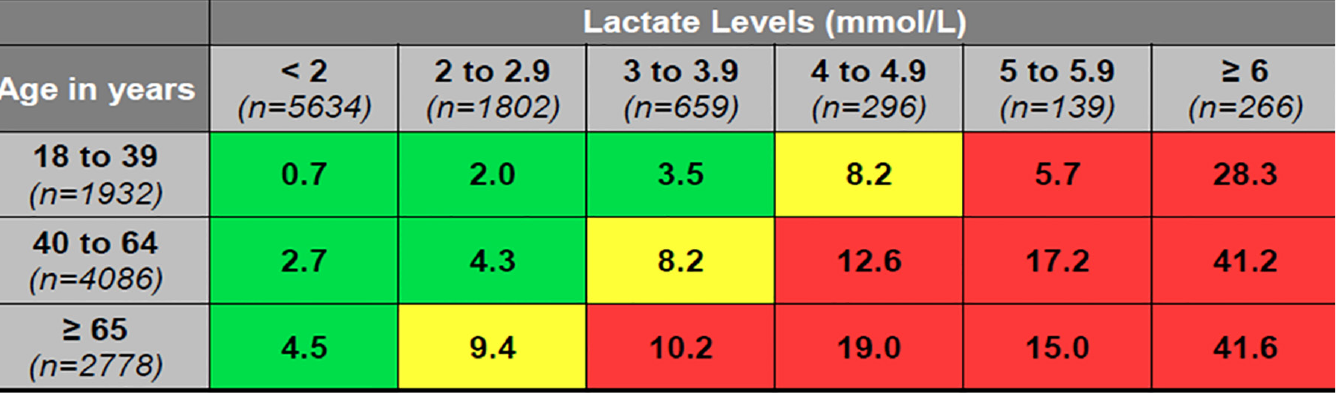
Figure 2. In-hospital mortality rate of ED patients by age and lactate level. *The mortality and lactate association within each age group row is significant with a p <0.0001. mmol/L, millimoles per liter; ED, emergency department.